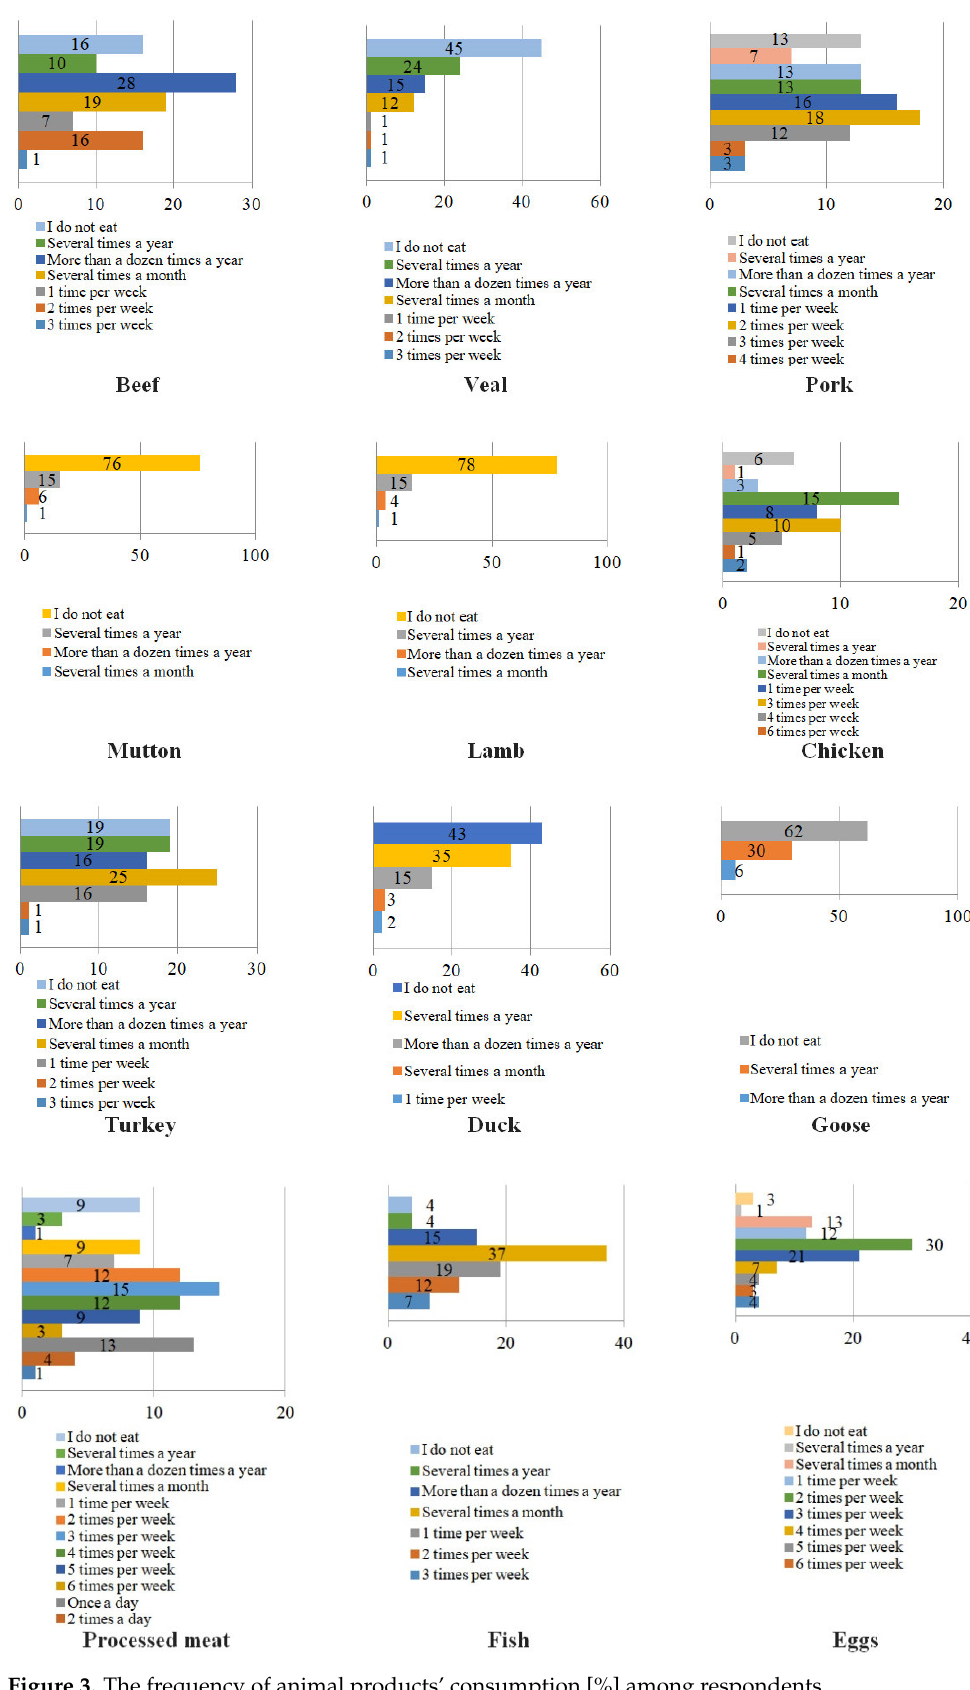
Figure 3. The frequency of animal products’ consumption [%] among respondents.